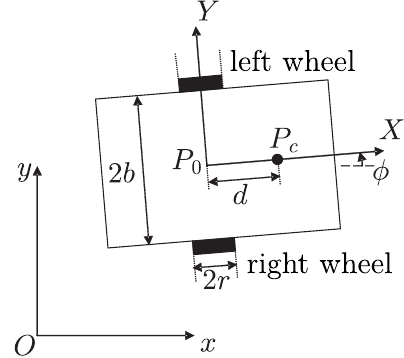
Figure 1. Wheeled mobile robot under